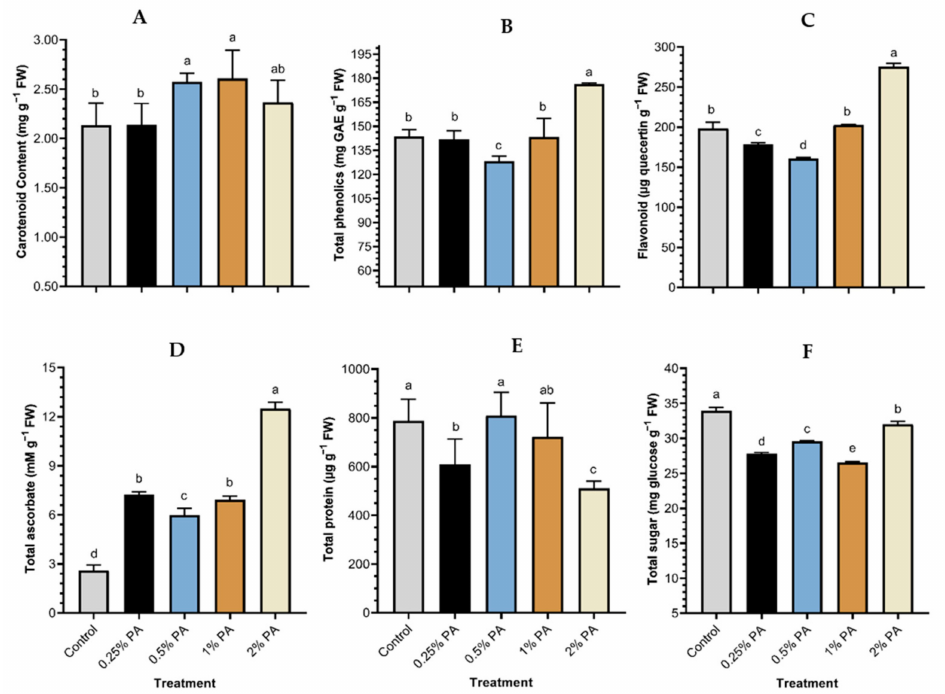
Figure 3. Tomato ‘Scotia’ fruit biochemical content in response to pyroligneous acid treatment: ( A ) carotenoid content, ( B ) total phenolic content, ( C ) flavonoid content, ( D ) total ascorbate content, ( E ) total protein content, and ( F ) total sugar content. Values are the means of four replicates and different lowercase alphabetical letters indicate significant ( p < 0.05) difference according to Fisher’s least significant difference (LSD) post hoc test. Error bars show the standard